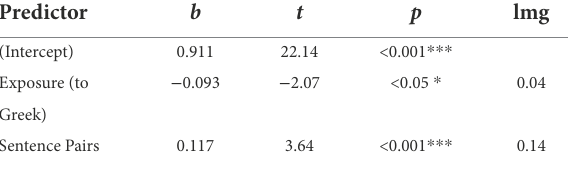
TABLE 6 Final model for the Greek